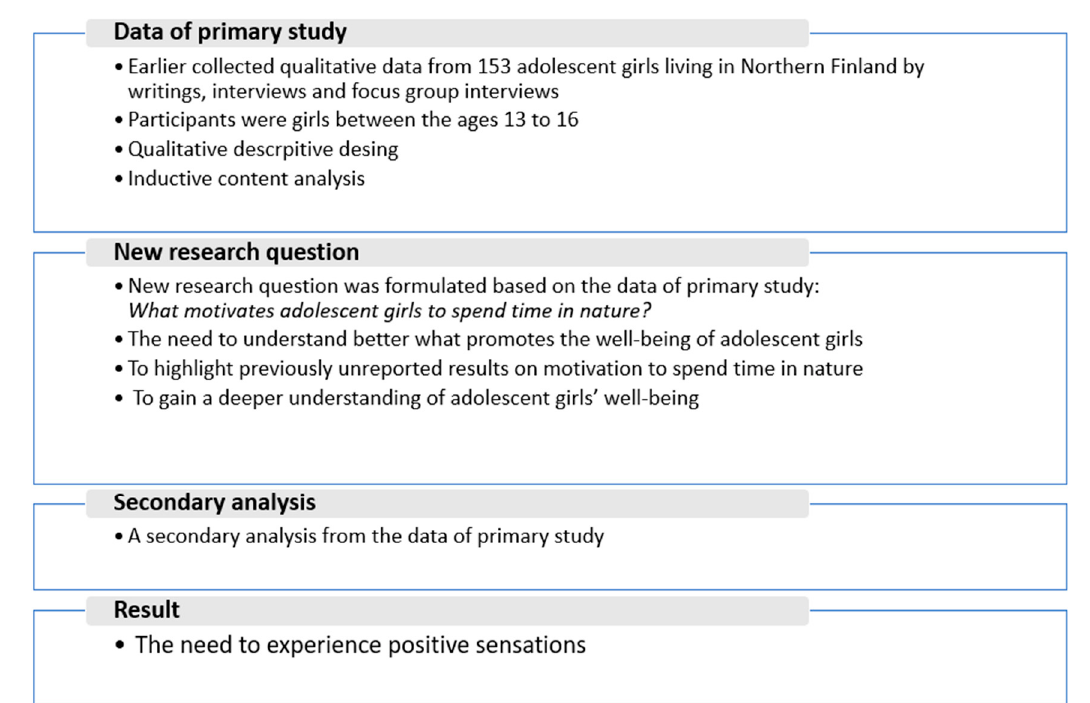
Figure 1. A secondary analysis of qualitative data from preexisting data of primary study.